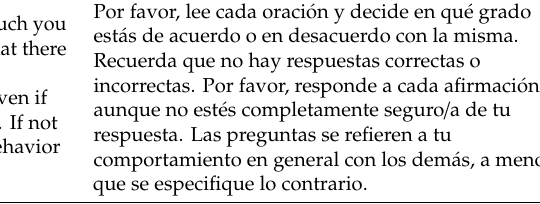
Table A1. Spanish version of the Dark Core Scale